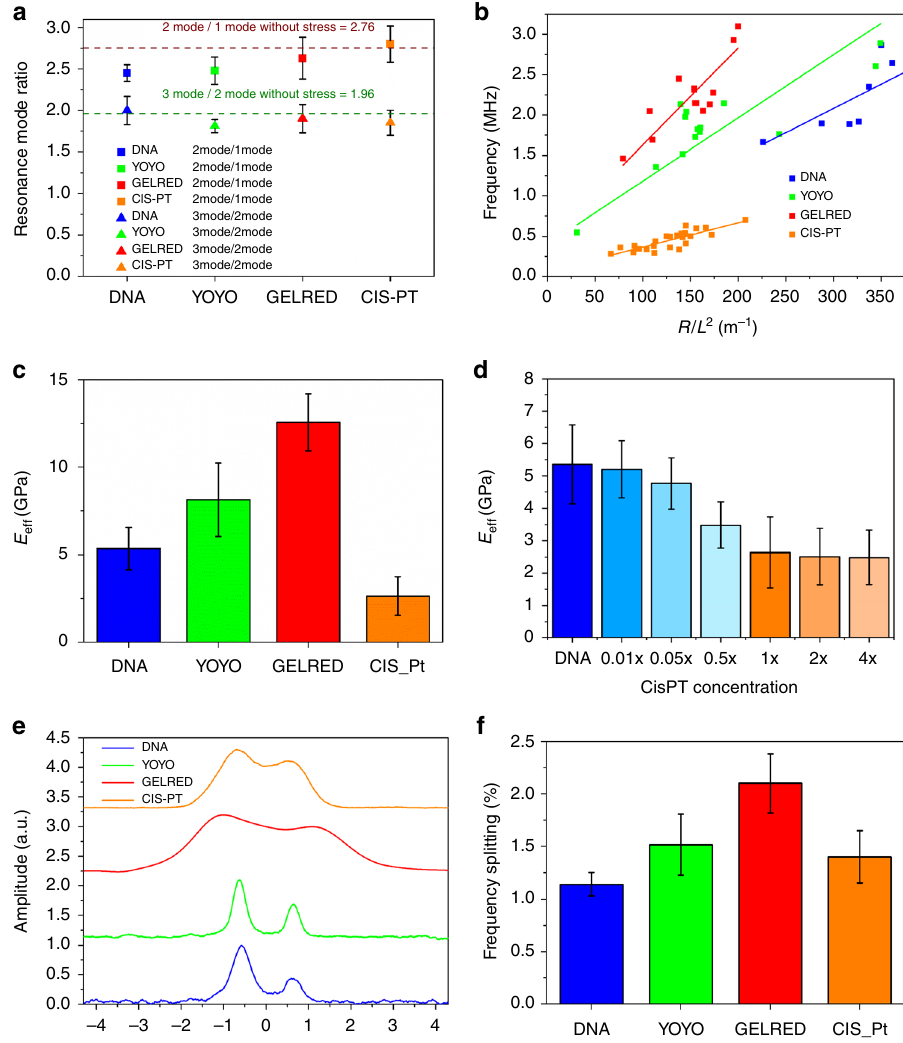
Fig. 6 Mechanical properties of intercalated DNA. a Resonance mode ratio evaluated on bare DNA resonators and DNA intercalated with YOYO-1, GelRed, and CisPt. Dashed lines represent the theoretical value of the ratio between the resonance modes for a clamped – clamped beam without stress. b Frequency of the fundamental resonance mode as a function of the ratio of the bundle radius over the square of the length. The squares correspond to the experimental data and the lines to the linear fi t. c Effective Young ’ s modulus of the four different types of DNA resonators. Error bars were computed from the standard deviation of 25 measurements. d Effective Young ’ s modulus of DNA bundles prepared with different concentrations of CisPt. The 1× concentration is the sample reported in the other panels. e Splitting of the fi rst fl exural vibration mode observed in vacuum, due to the asymmetry in the bundle section geometry. The spectra are centered with respect to the average of the two fl exural modes. f Relative frequency splitting of the fl exural vibration mode of the four different types of DNA resonators. Error bars were computed from the standard deviation of 10 measurements. Source data